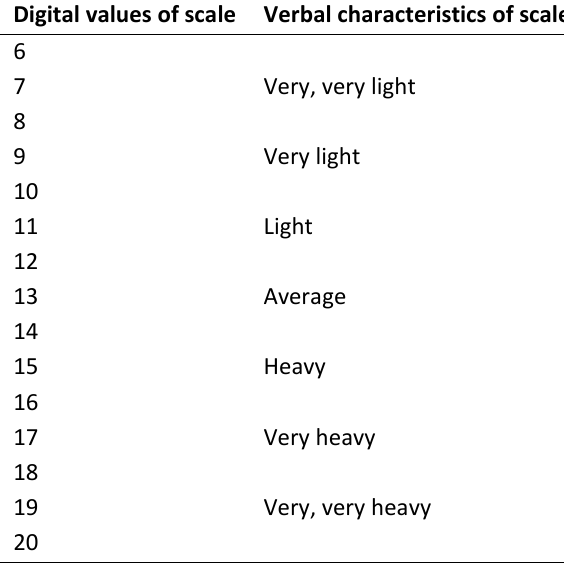
Table 1. Scale of subjective assessment of load’s heaviness (by G. Borg) [24,